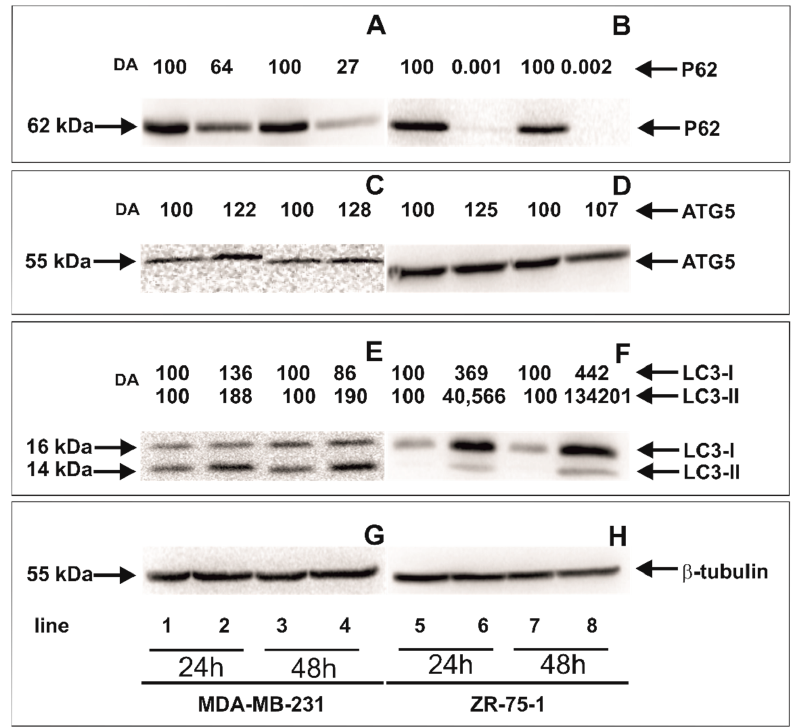
Figure 7. Western blot and densitometric analysis of P62 ( A , B ), ATG5 ( C , D ), LC3-I and LC3-II ( E , F ) expression in MDA-MB-231 ( A , C , E ) and ZR-75-1 ( B , D , F ) cells incubated with 100 µ g/mL of rGO (lines 2, 4, 6 and 8) in comparison to untreated control cells (lines 1, 3, 5 and 7) for 24 (lines 1, 2, 5 and 6) and 48 h (lines 3, 4, 7, and 8). Samples containing 15 µ g of protein were submitted to electrophoresis and immunoblotting. A representative Western blot is presented. Densitometric analysis was presented as a relative fold change in comparison to untreated controls, where expression level was set as 100. The expression of β -tubulin ( G , H ) served as a control for protein